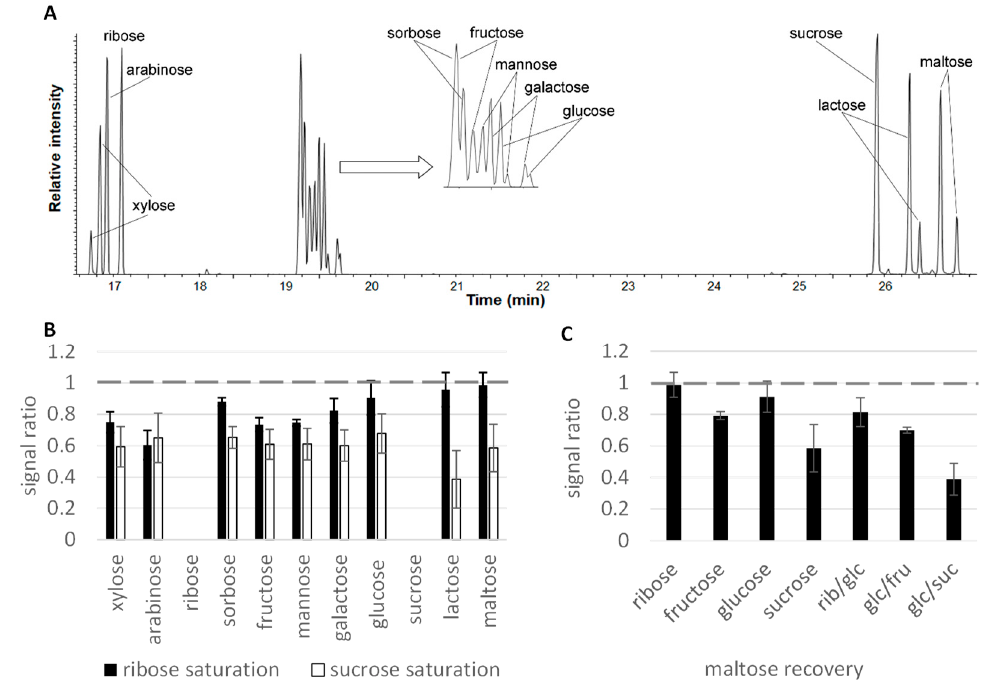
Figure 3. Matrix effects between sugars. ( A ) Chromatogram illustrating the elution order of the nine investigated carbohydrates. ( B ) Recovery of nine sugars (120 µM) in presence of ribose and sucrose in saturation (5 mM). Analytes are listed in order of decreasing retention, with ribose and sucrose included to illustrate the elution order. ( C ) Maltose (120 µM) recovery in presence of other sugars in saturation (5 mM). Analyzed on an Agilent GC 6890.